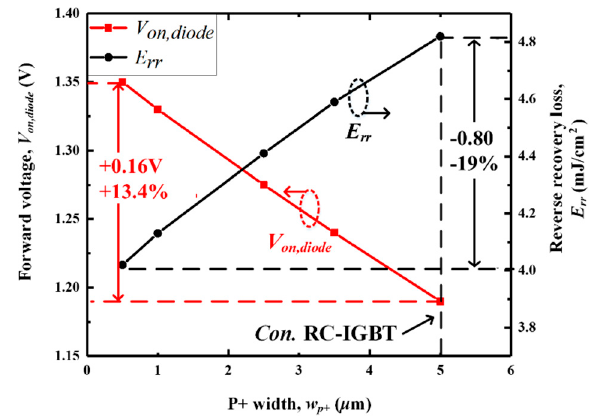
Figure 8. The change of the V on.,diode and E rr with different P+ emitter widths. Figure 9 shows the inductive load circuit for the switching simulation of RC-IGBT. The inductive load is set to 200 μ H. The IGBT turn-o ff characteristics of Con. RC-IGBT